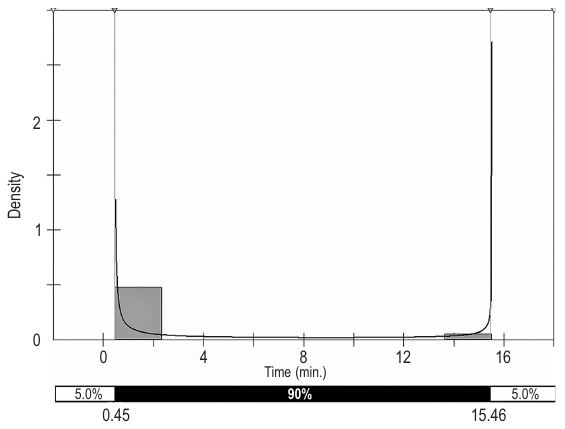
Fig. 8. Statistic distribution of the measured duration data for the activity of “ Dropping winch hook ” in the installing process before removing outlier